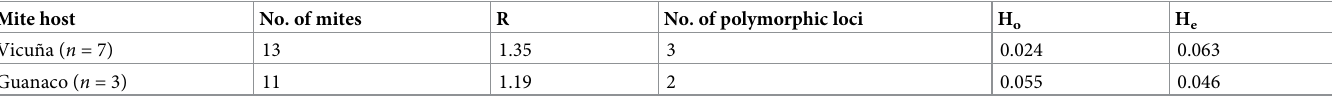
collected from seven vicu ñ as and 11 mites collected from three guanacos. Sixteen alleles were detected across 10 microsatellite loci. Depending on the loci, allele count ranged from one (SARM-36 and 38) to three (SARM-33 and 40). A total of 6 private alleles (i.e. alleles found only in one population and among the broader collective populations of study) were detected and distributed among eight loci (SARM-33, 35, 37, and 40). The distribution and allele fre- quencies among populations of S . scabiei mites according to the host is presented in Table 3. Vicu ñ a-derived mites had more total alleles detected overall (n = 14) compared to mites collected from guanacos (n = 12); however, both mite camelid-derived populations displayed relatively low allelic richness (R = 1.35, R = 1.19, Table 4). Further, mites from vicu ñ a guanaco Table 4. Characteristics of genetic variability of Sarcoptes scabiei obtained from vicu ñ a and guanaco carcasses in San Guillermo National Park. Mite host No. of mites R No. of polymorphic